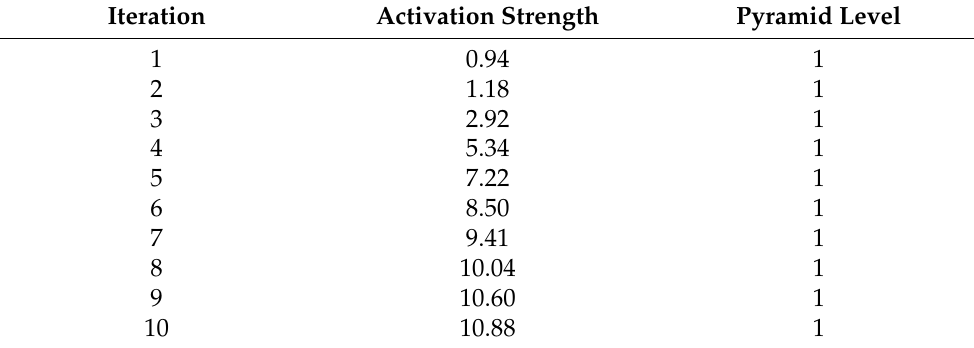
Table 5. Activation strength on 56 features learned by the average pooling layer for